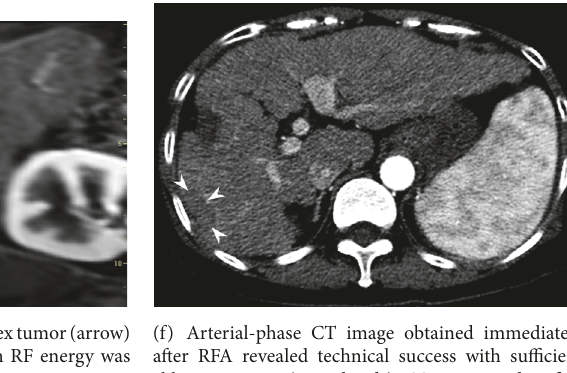
Figure 3: Images from a 59-year-old woman with a 1.1-cm HCC and hepatitis B virus-related liver cirrhosis who had previously undergone percutaneous RFA of